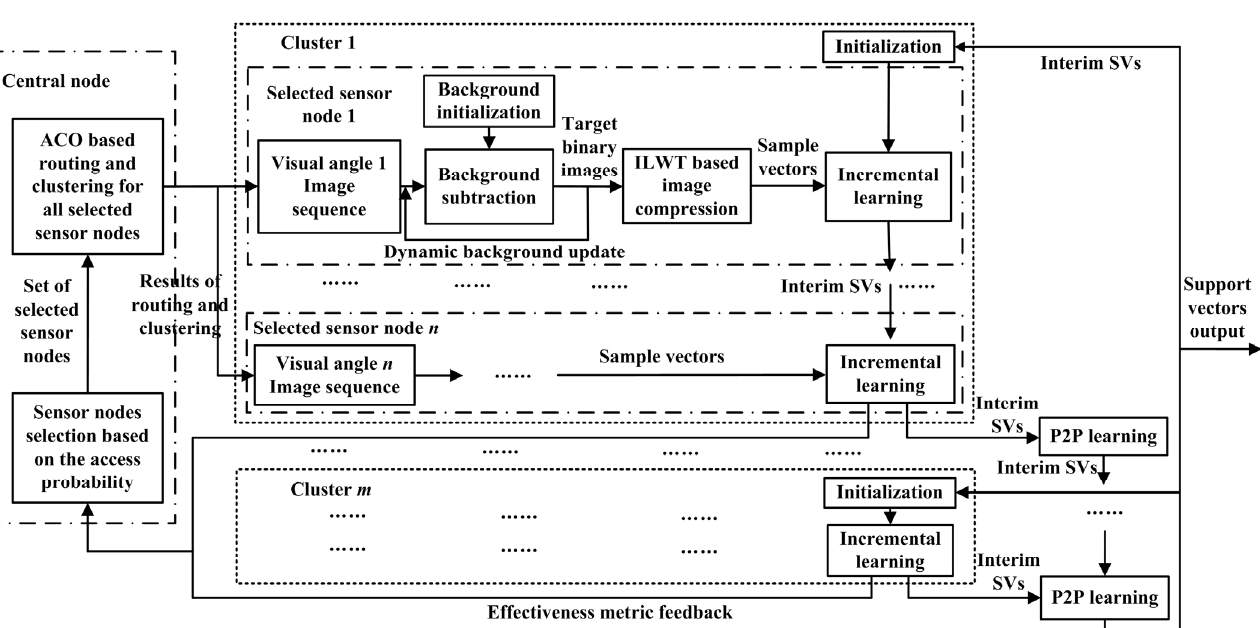
Figure 5. Overview of collaborative hybrid learning